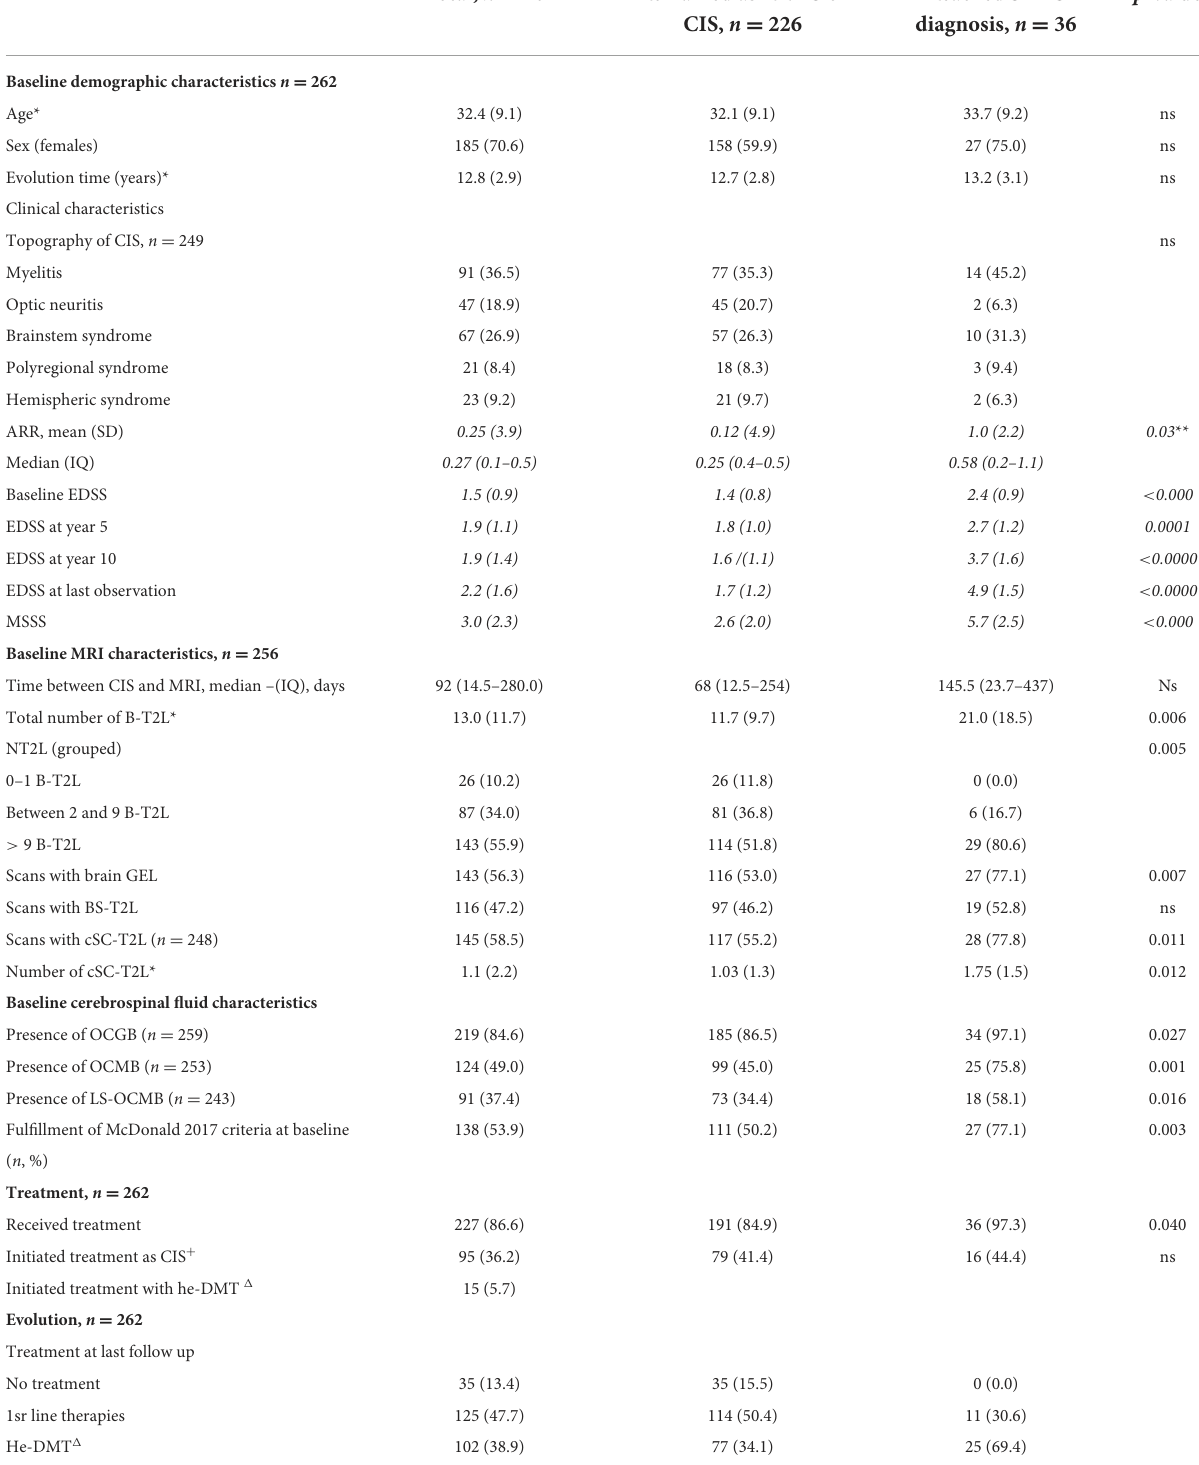
Total, n = 262 Remained as RRMS or